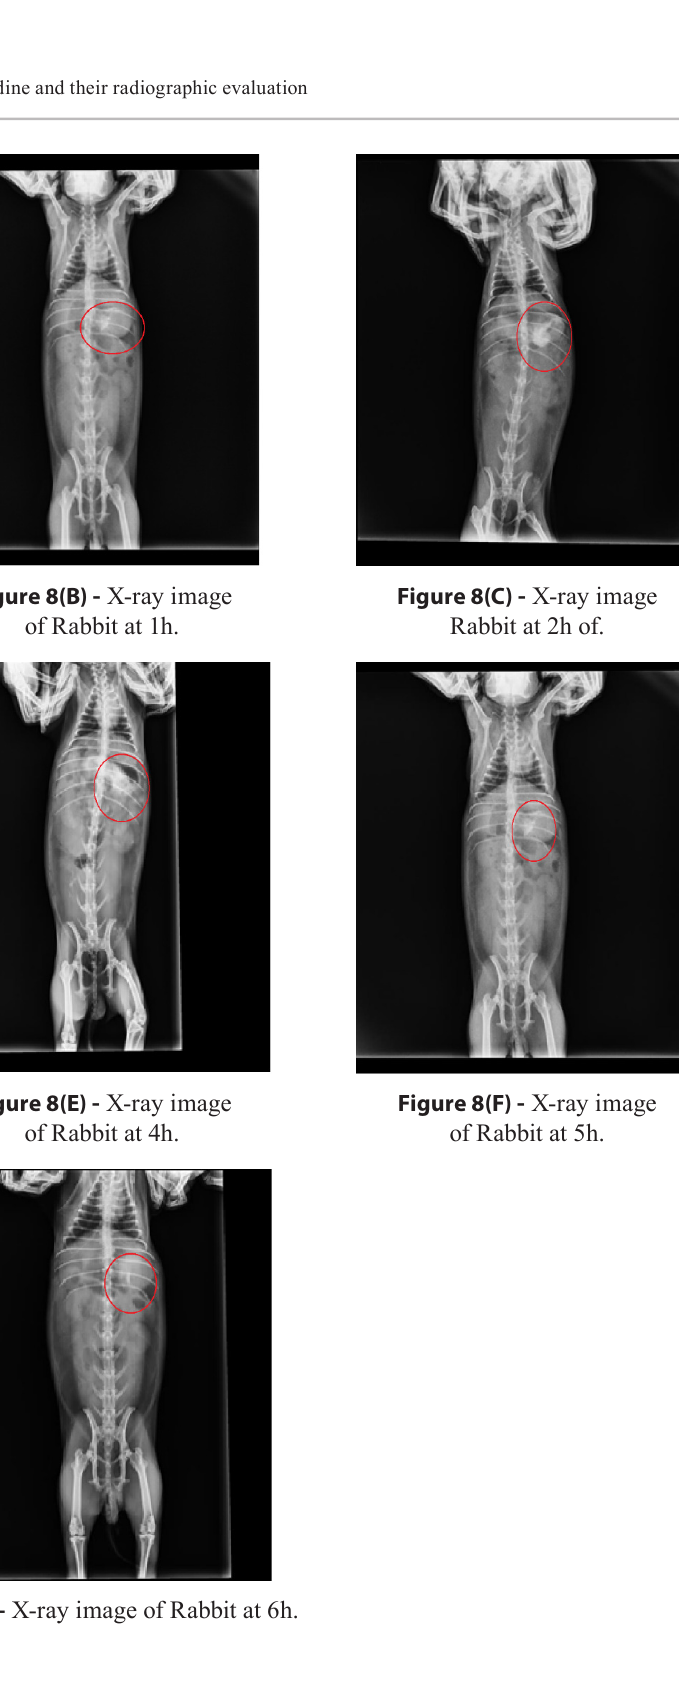
Fig. 8(G) - X-ray image of Rabbit at